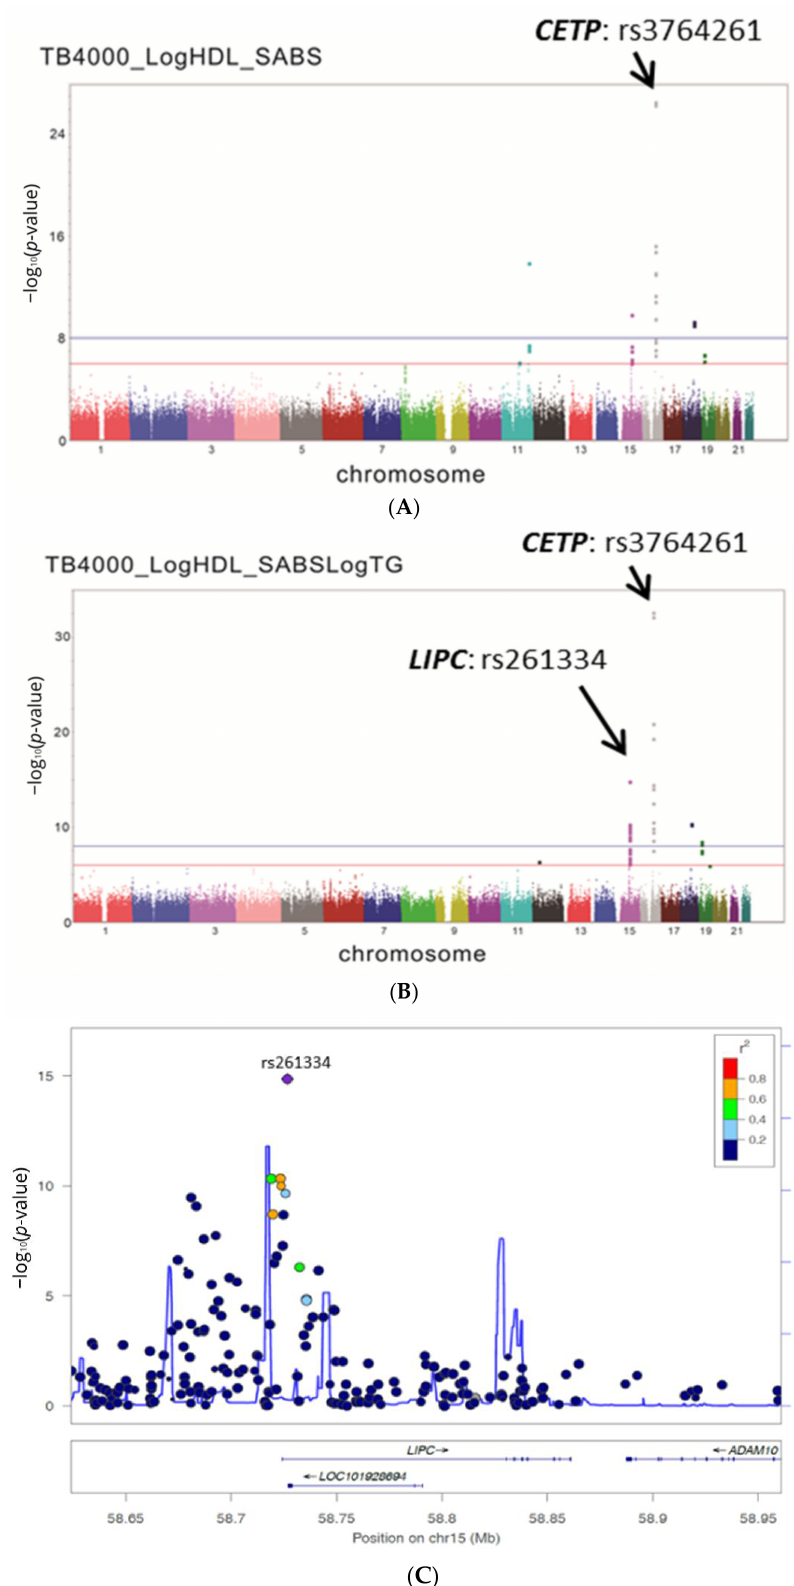
Figure 1. Genome-wide association studies (GWAS) analysis of high-density lipoprotein cholesterol (HDL-C) levels and LIPC variants. ( A ) Manhattan plot; ( B ) Manhattan plot after adjustment for TG; ( C ) Genetic region of rs261334 on chromosome 15.